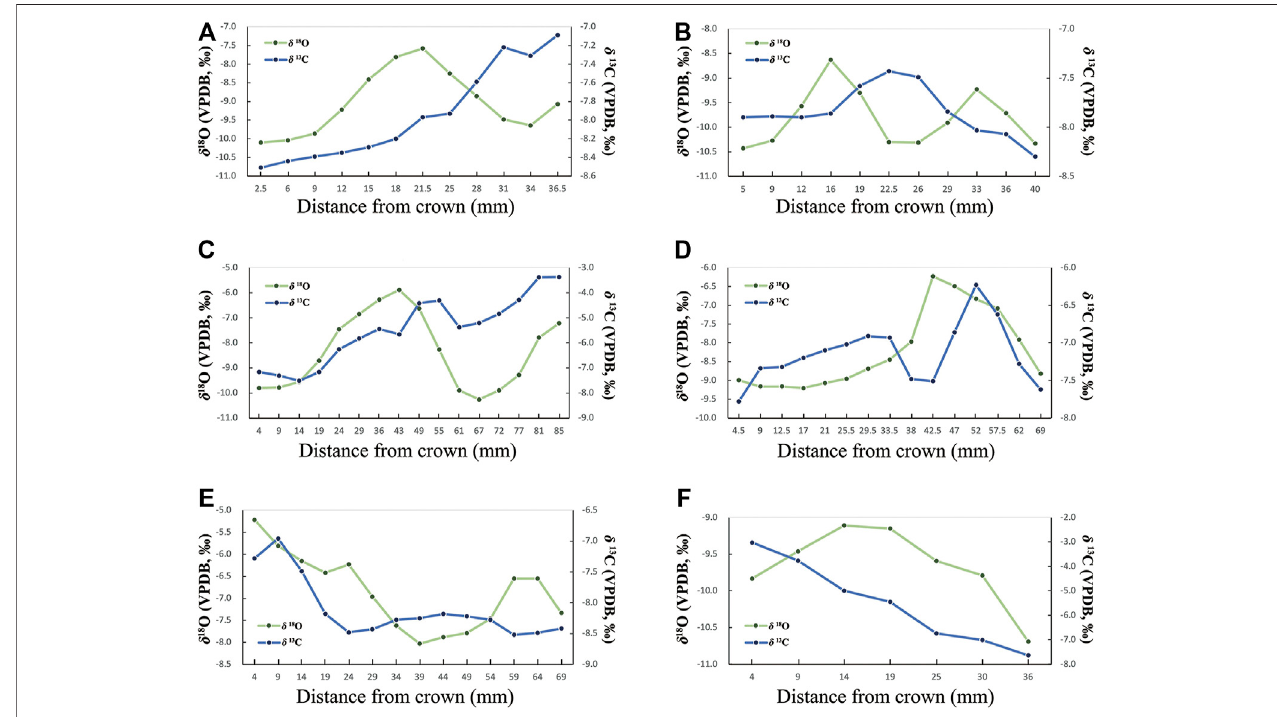
TABLE 2 | Serial sampling data of MDG teeth. Taxa Lab code n δ 13 C ( ‰ ) δ 18 O ( ‰ )